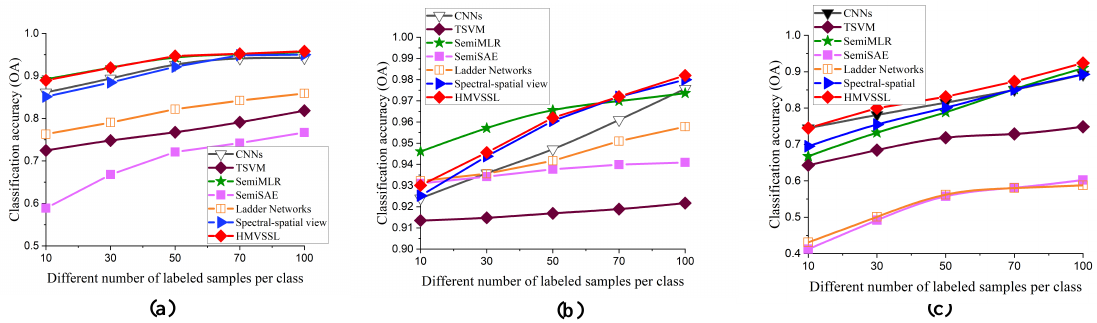
Figure 14. Classification accuracies of the comparisons with different numbers of labeled samples per class: ( a ) Aeria data. ( b ) JX_1 data. ( c ) Pavia University